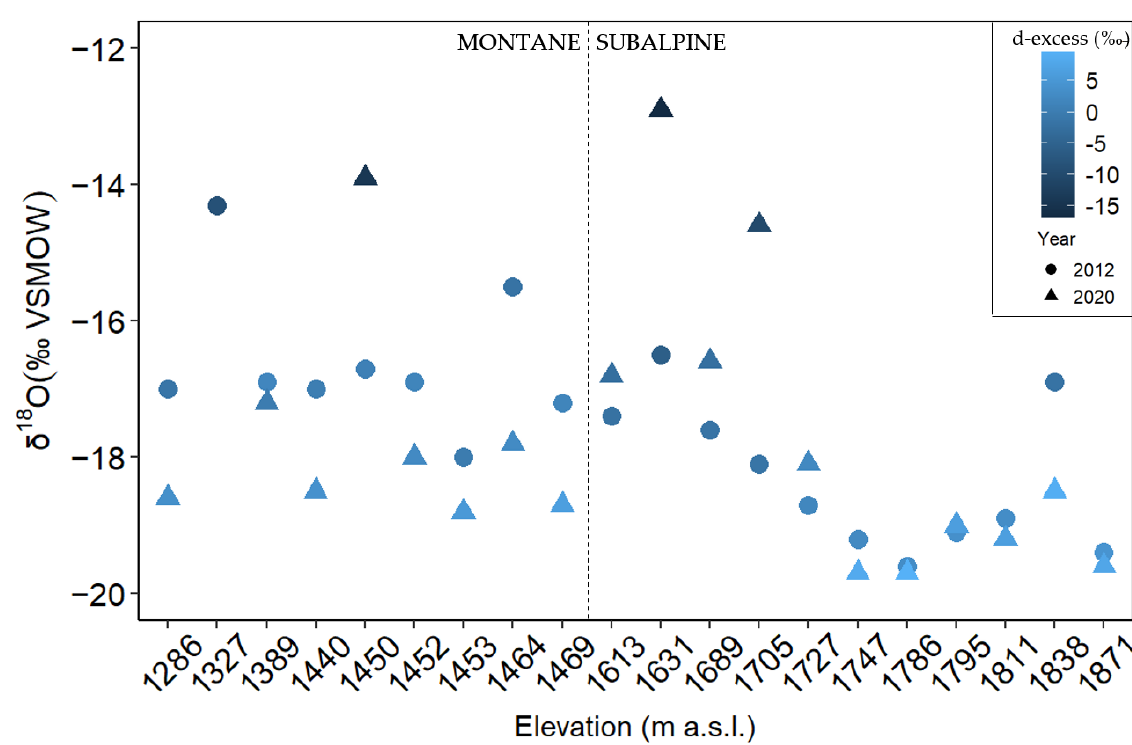
Figure 6. δ 18 O and d-excess values shown for extensive wetland pond surface water samples across the Montane and Subalpine Natural Subregions. Year is depicted by symbol shape and, d-excess is depicted by color.